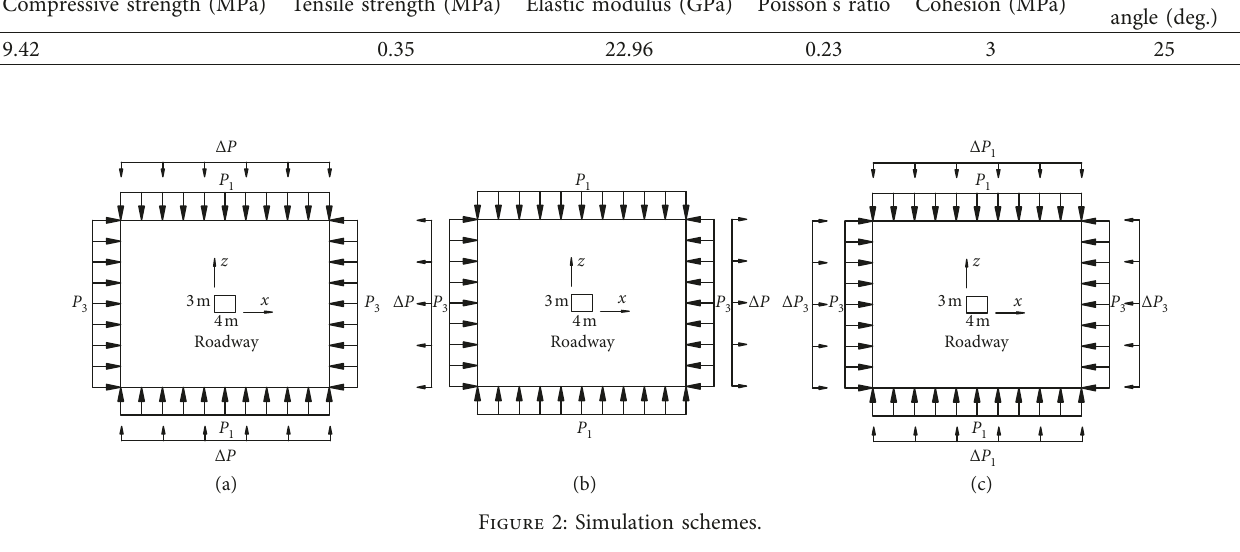
Figure 2: Simulation schemes.